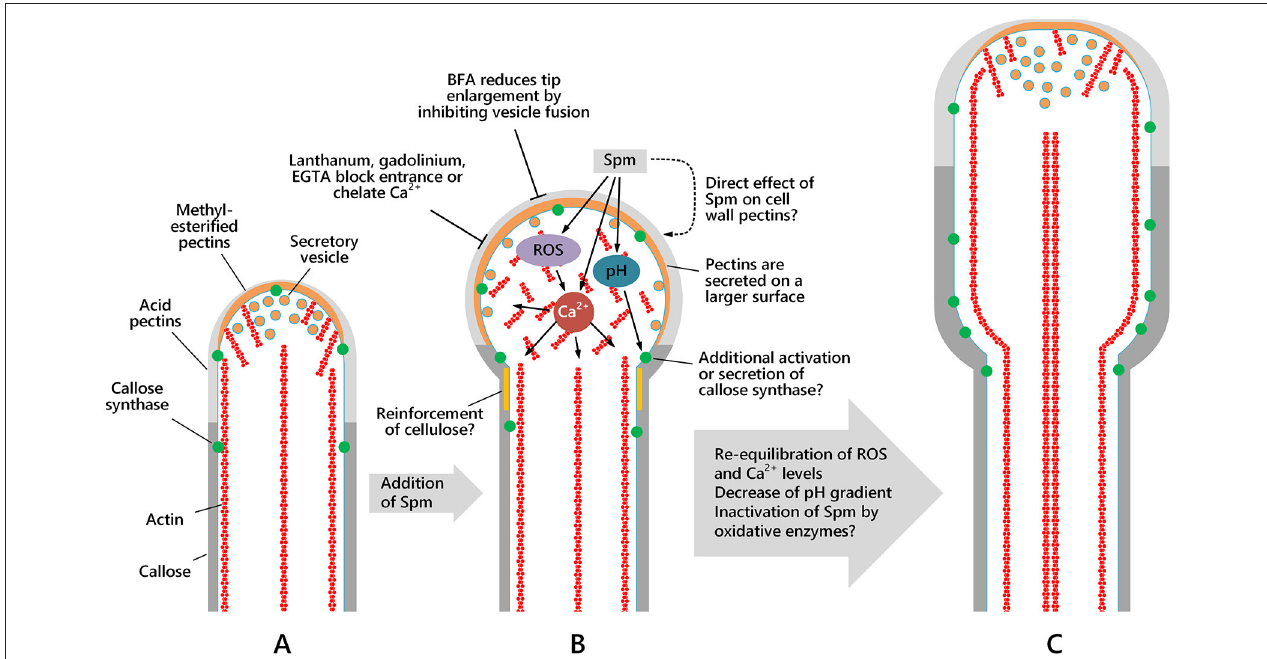
FIGURE 13 | Schematic drawing showing the morphology of the apical region and the spatial distribution of actin filaments, secretory vesicles and cell wall components in pollen tubes and how Spm perturbs either their distribution or the morphology of the apical region. The pollen tube sub-apex is characterized by the actin fringe while in the shank region actin filaments form regular and longitudinal cables, which are essential for organelle and vesicle movement. Spm profoundly alters Ca 2 + , H + , and ROS concentrations and distribution, thereby affecting not only microfilament organization but also vesicle delivery. As a final result, assembly of the cell wall and shaping of the growing pollen tube tip is altered. (A) Pollen tube after 1h of germination; (B) pollen tube after 1h of germination in standard medium, then supplied with Spm for one additional hour; (C) pollen tube grown for 1h in standard medium and then supplemented with Spm for two additional hours. As yet unknown mechanisms re-equilibrate ion distribution and concentration and allow the pollen tube to resume growth even though tube diameter remains larger and growth rate slower. Inactivation of Spm by oxidative enzymes cannot be